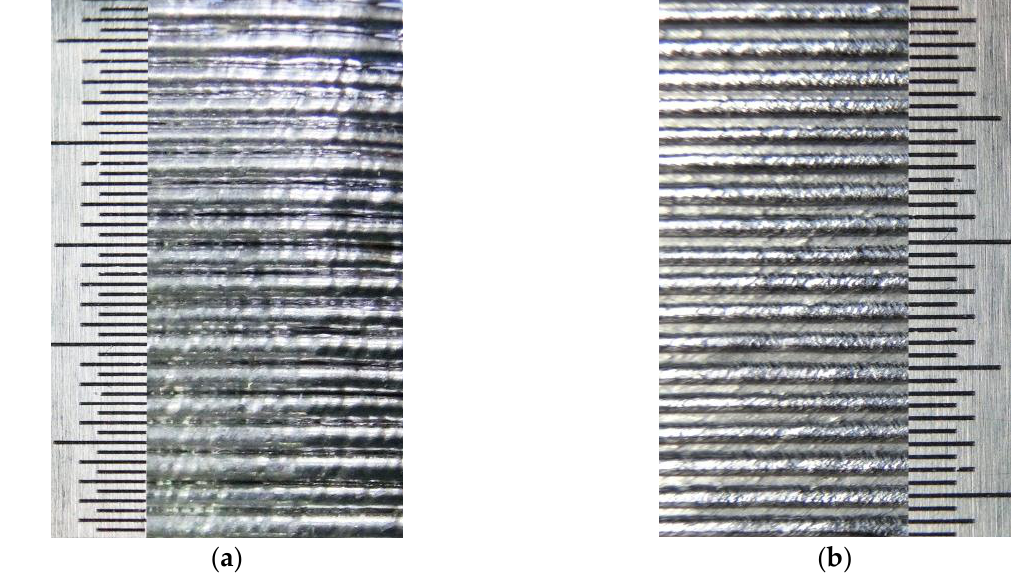
Figure 5. The deposited specimens in different layer thickness. ( a ) δ = 1.5 mm. ( b ) δ = 1.2